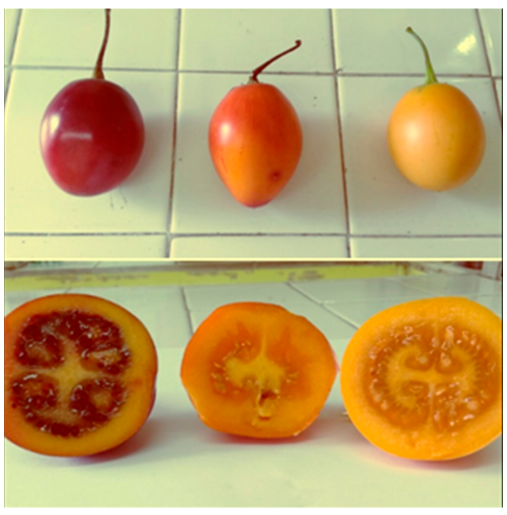
Figure 1. Commercial varieties of tamarillo, red; orange; and yellow-fleshed fruits.